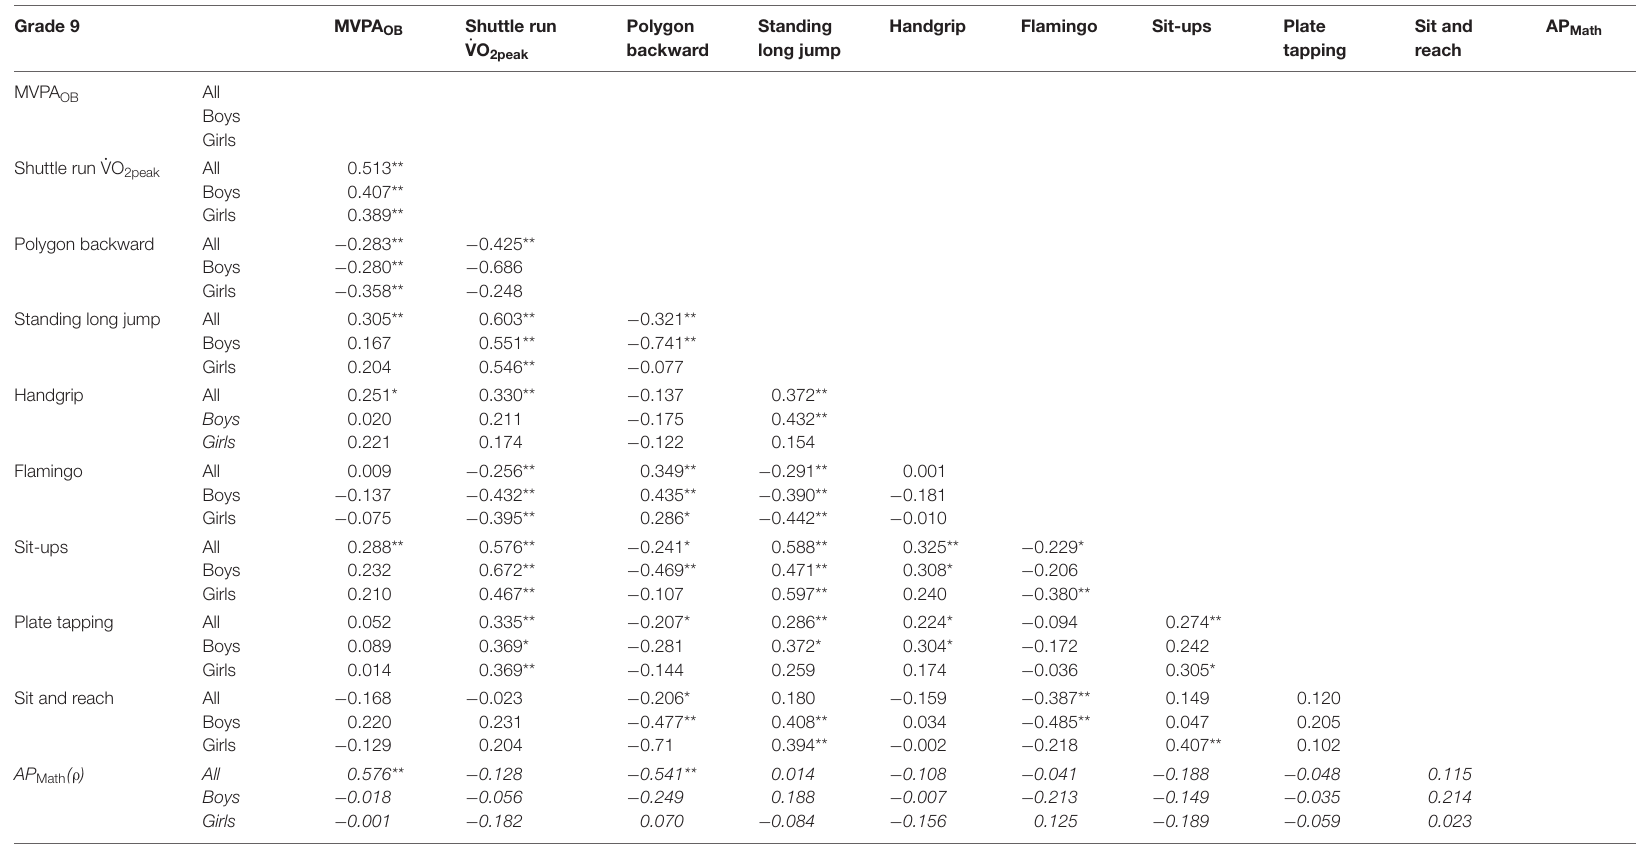
Aerobic power calculated from 20 m shuttle run ( ˙ VO 2peak ) following the Leger protocol (Leger and Lambert, 1982) and expressed in mL · kg − 1 min − 1 ; MVPA OB , physical activity measured directly using SenseWear Armbands in N = 50 sub-sample (21 boys and 29 girls); AP math : academic performance (math grade, corresponding to the final grade awarded at the end of Grade 8); *Significant correlation p < 0.05; **Significant correlation p < 0.01; Italics font represents non-parametric correlations (Spearman